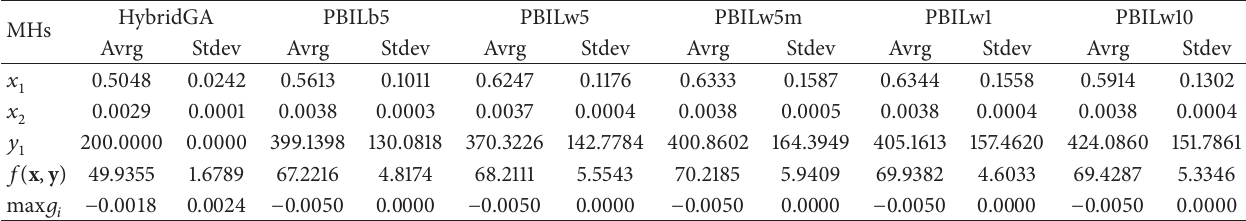
Table 1: Optimum results of